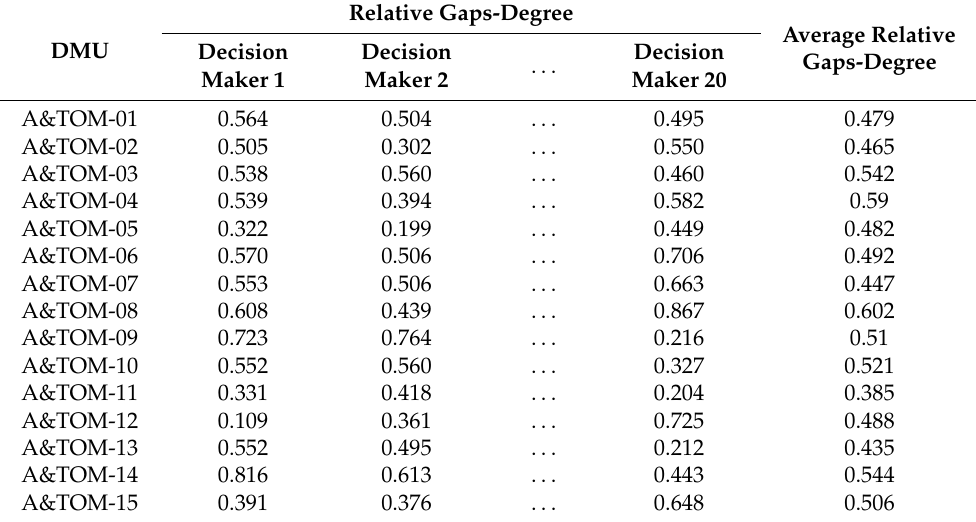
Table 15. Relative gaps-degree average value.